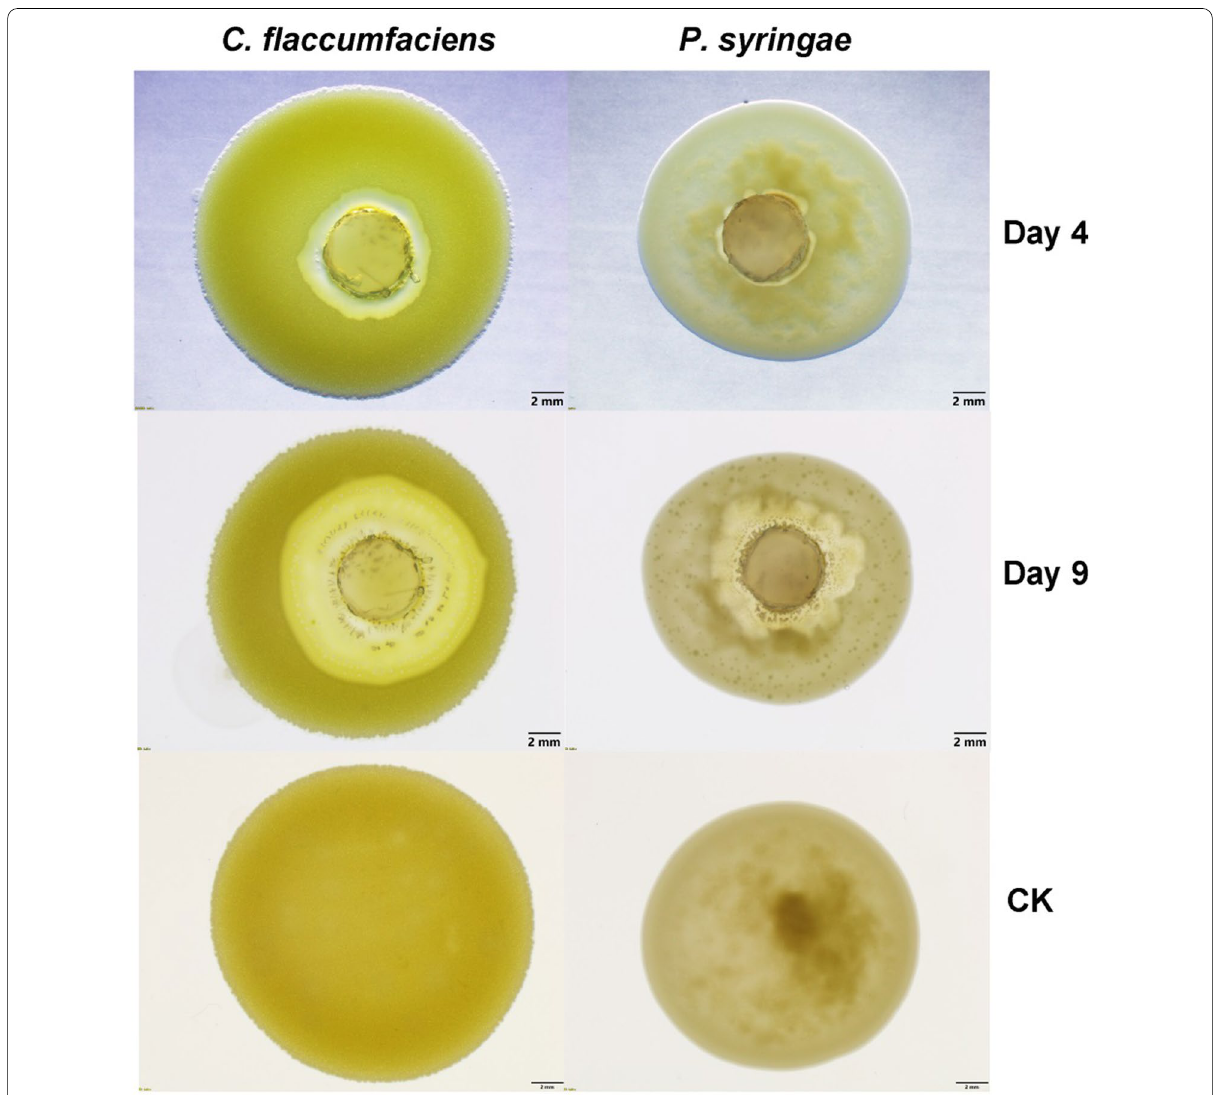
Fig. 1 The predation of c25j21 against plant pathogenic bacteria C. flaccumfaciens and P.